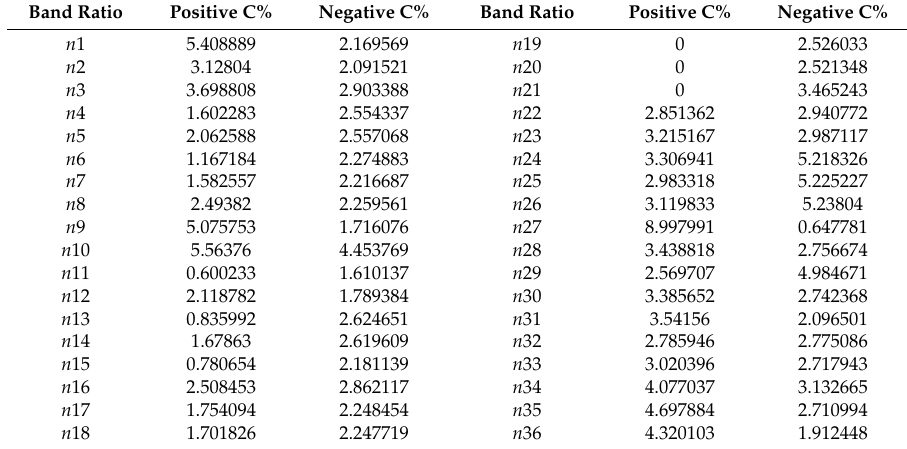
Table 4. Contribution percentage of band ratios n 1– n 36 in the construction of resultant principal components for a selected subset of the study area.